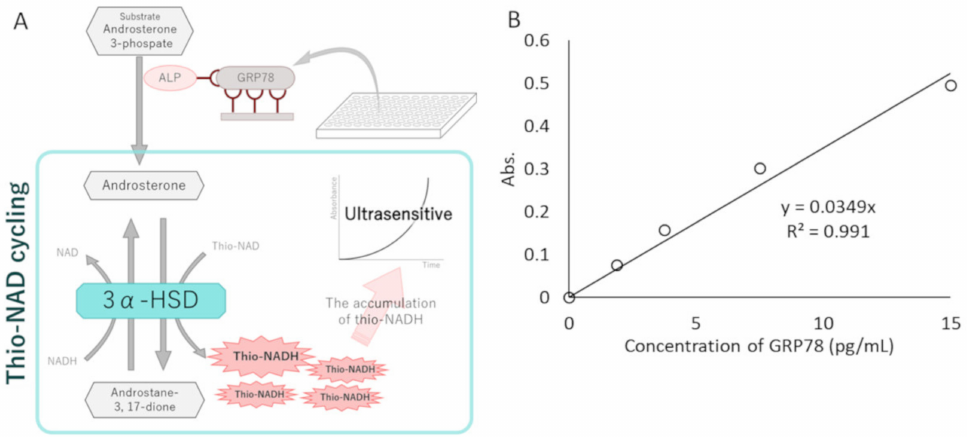
Figure 1. GRP78 measurements using an ultrasensitive ELISA with thio-NAD cycling. ( A ) Schematic representation of an ultrasensitive ELISA with thio-NAD cycling. A conventional sandwich ELISA was combined with a thio-NAD cycling assay, producing signals in a quadratic-function-like response (i.e., triangle number) over time. This system comprised ALP linked with a secondary antibody against the target protein, an androsterone derivative as the first substrate, 3 α -HSD as the enzyme for thio-NAD cycling, and their coenzymes (NADH and thio-NAD). Thio-NADH accumulation